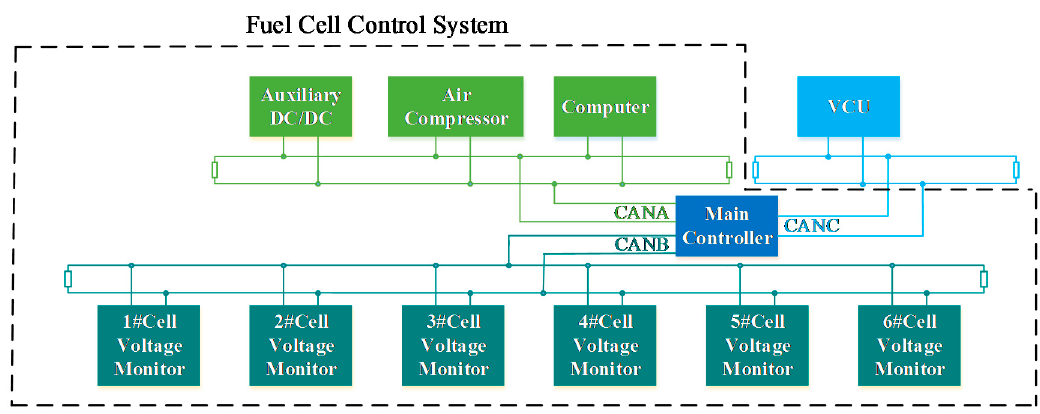
Figure 5. Network of the fuel cell system.